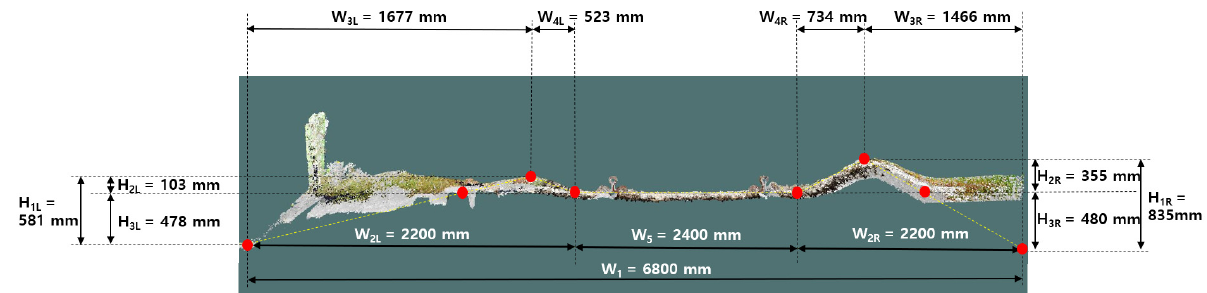
Figure 8. Extraction of the values of representative parameters for the sleeper scan data (1).